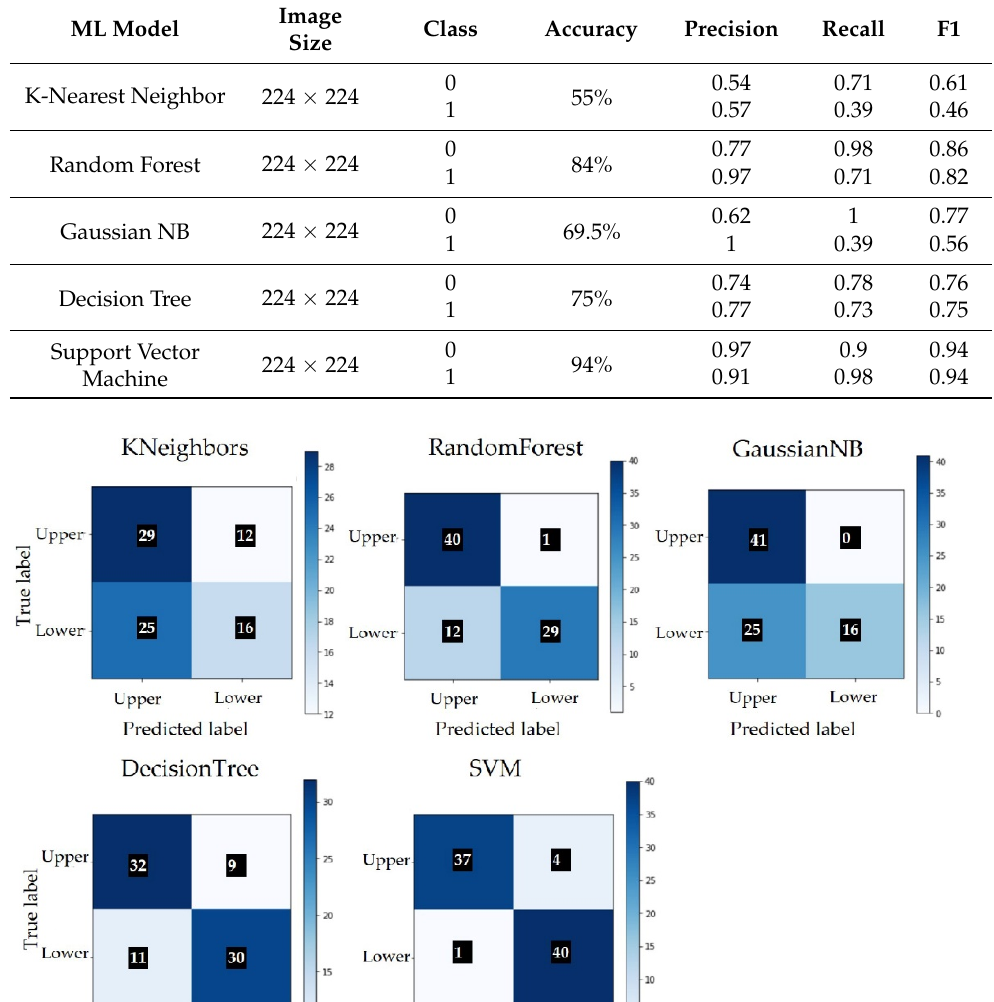
Table 5. Classification results obtained on the tested dataset.